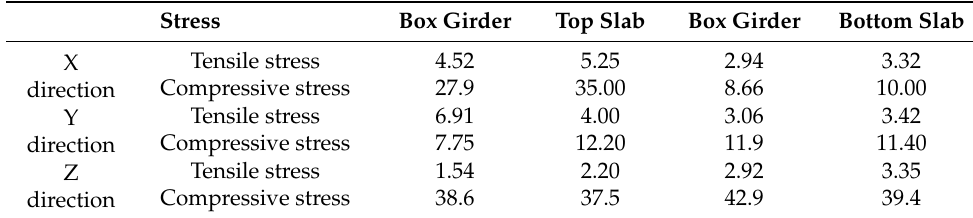
Figure 3. Full-scale specimens: ( a ) top slab; and ( b ) bottom slab. Table 1. Comparison of local and overall maximum stress (Unit: MPa).